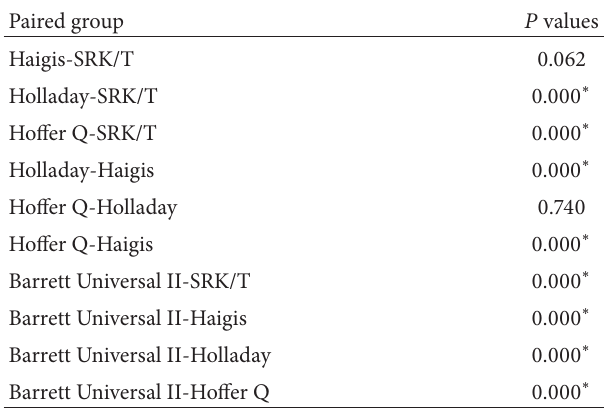
Table 5: Difference in absolute error between different